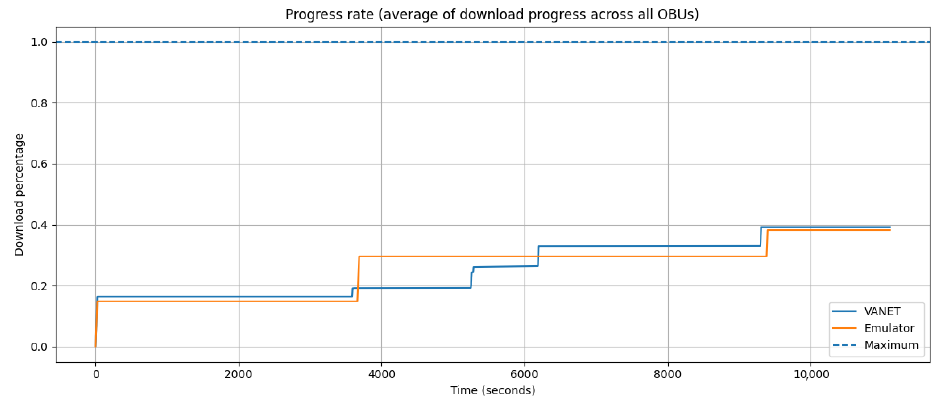
Figure 10. Scenario 2: Comparison of download times of a 50 MB file dissemination in a 5 node VANET using IPFS vs. EmuCD using IPFS.